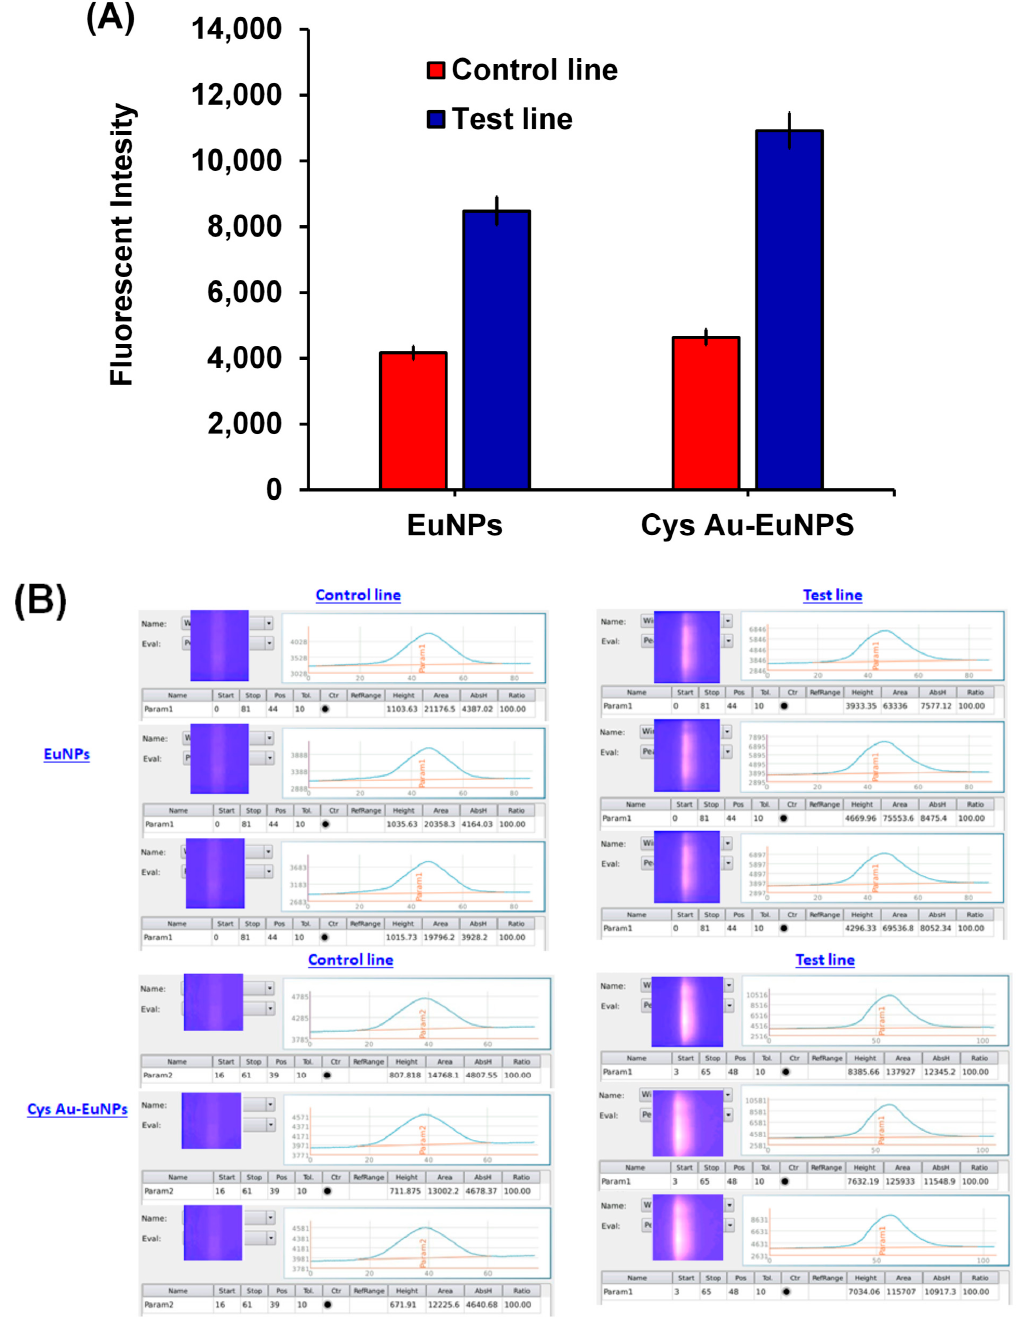
Figure 10. ( A ) Fluorescence intensity for CL and TL of EuNPs and Cys AU-EuNPs; ( B ) Raw data describing medisensor information.